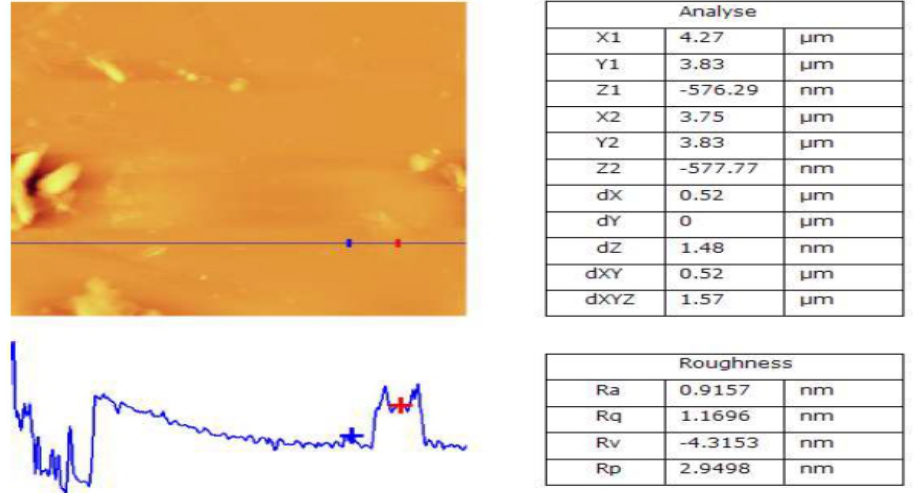
Fig. 5. AFM Images of GO and GO-ZnO-Mn